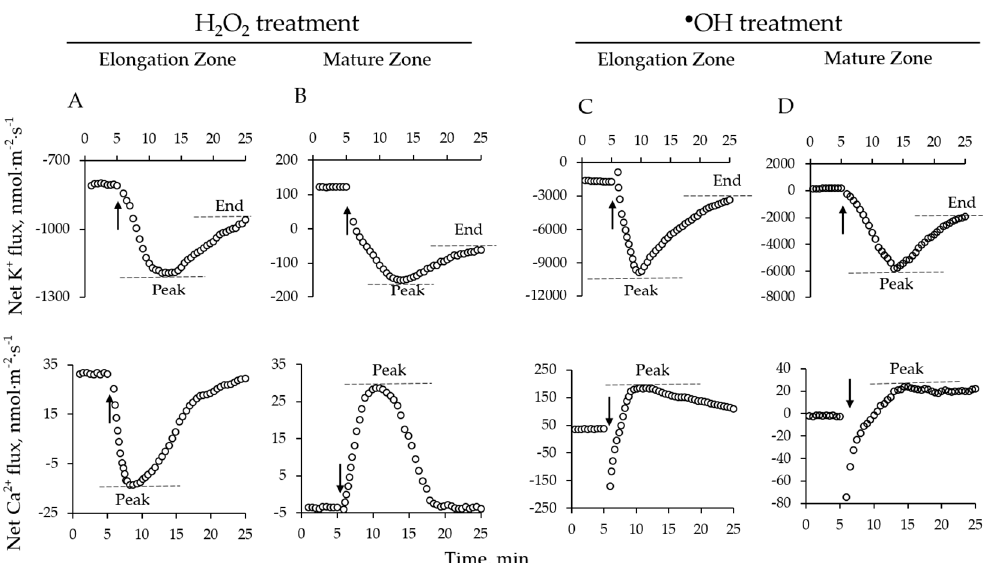
Figure 1. Descriptions (see inserts in each panel) of cereal root ion fluxes in response to H 2 O 2 and hydroxyl radicals ( ● OH) in a single experiment. ( A , B ) Ion flux kinetics in root elongation zone ( A ) and mature zone ( B ) in response to H 2 O 2 ; ( C , D ) Ion flux kinetics in root elongation zone ( C ) and mature zone ( D ) in response to ● OH. Two distinctive flux points were identified in kinetics of responses: peak value-identified as a maximum flux value measured after a treatment; end value-identified 20 min after the treatment application. An arrow in each panel represents when oxidative stress was imposed.